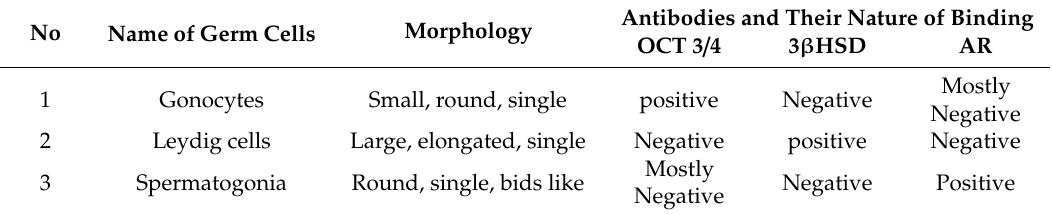
Table 4. Summary of the binding nature of the specific antibodies with germ cells of male pup testes.